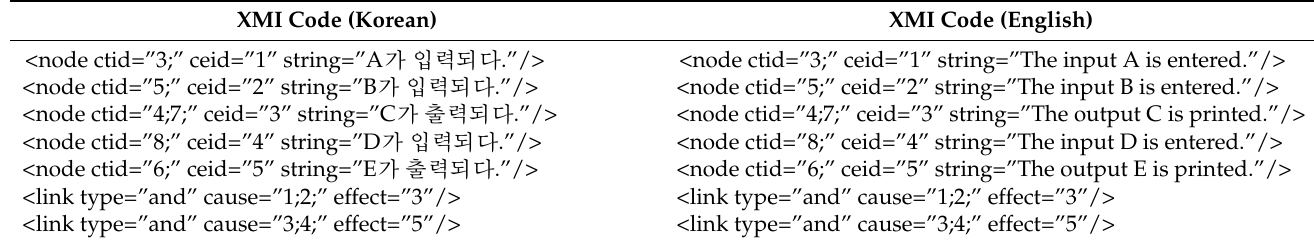
Table 11. XMI Code of Cause-Effect